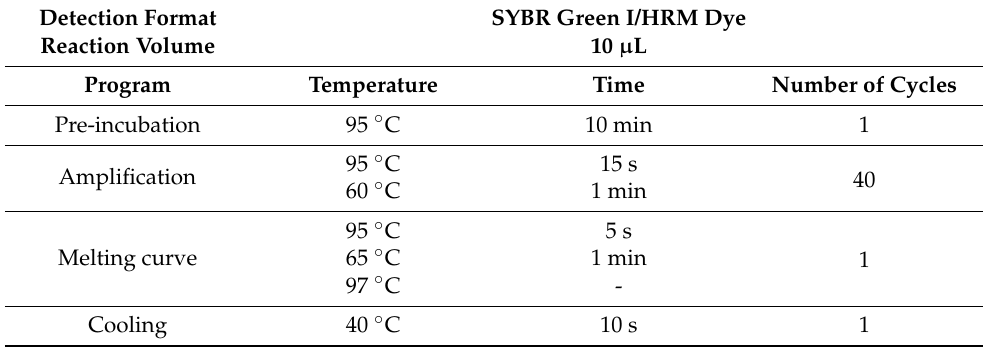
Table 7. ChIP RT-qPCR reaction